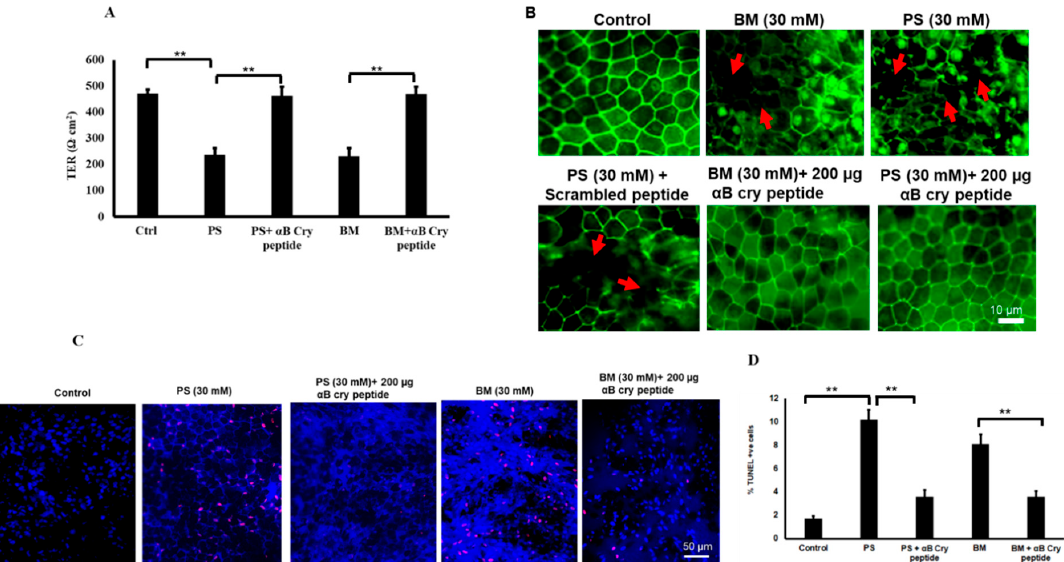
Figure 9. Inhibition of mGSH carriers results in loss of TER and junctional proteins in RPE which is rescued by α B cry peptide. ( A ) TER was significantly decreased when both OGC and DIC were inhibited. Coincubation with α B cry peptide (200 µ g / mL) restored TER almost close to that of the TER of control cells. ( B ) Inhibiting OGC or DIC significantly decreased TER of polarized RPE monolayers. LSM confocal microscopy images showing breaks (arrows) in ZO-1 staining with 30 mM PS or BM. Co-treatment with α B cry peptide (200 µg/mL) prevents ZO1 damage (** p < 0.01 represents DIC or OGC inhibited vs. α B cry peptide treated monolayers). ( C ). Polarized RPE cells were treated with PS or BM (30 mM) for 24 h and cell death determined by TUNEL assay. ( D ) quantification of TUNEL positive cells. Inhibition of mGSH transporters OGC and DIC significantly increased percentage of apoptotic cells. Cotreatment with 200 µg/mL α B cry peptide significantly prevented cell death. ** p < 0.001.